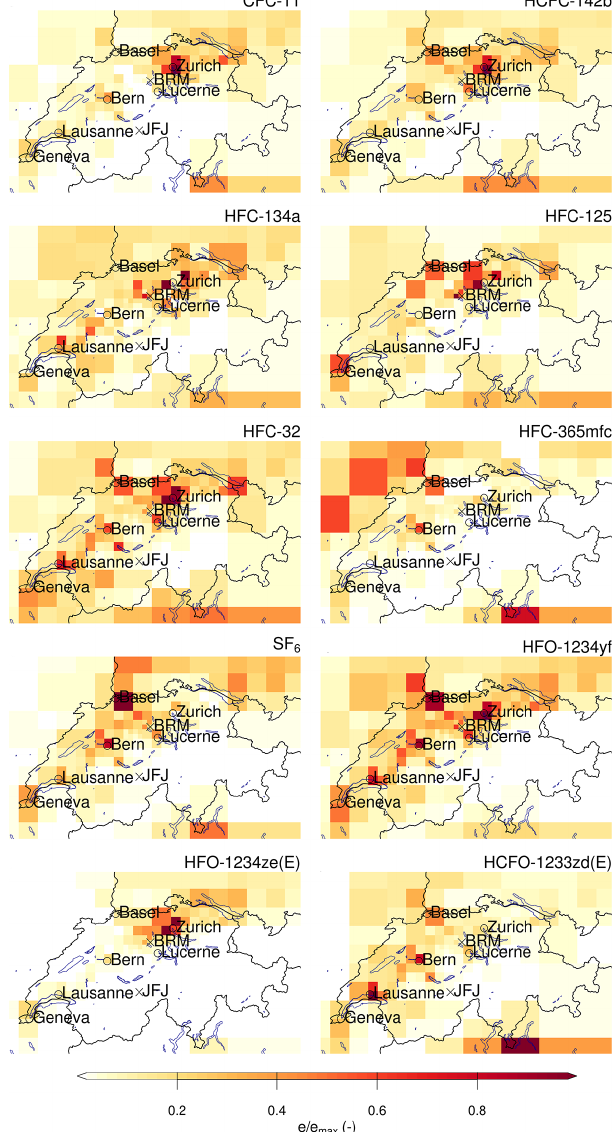
Figure 6. Emission maps for Switzerland generated from the Bayesian inverse (BI) modelling. Beromünster (BRM), Jungfrau- joch (JFJ), and major Swiss cities are indicated. Gridded emis- sions ( e ), given in micrograms per second per square kilometre (µgs − 1 km − 2 ), are scaled to the global maximum ( e max